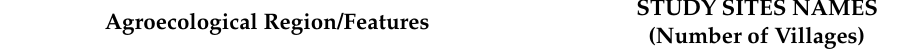
Table 1. Characteristics of the study